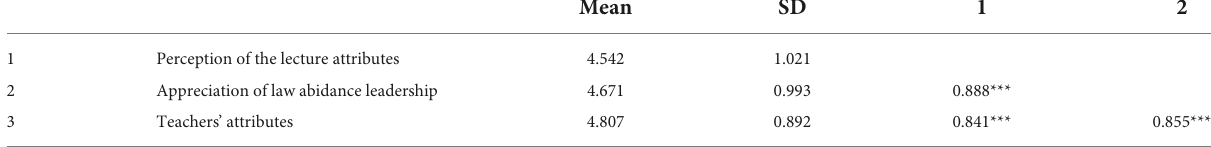
TABLE 1 Descriptive statistics and correlations among